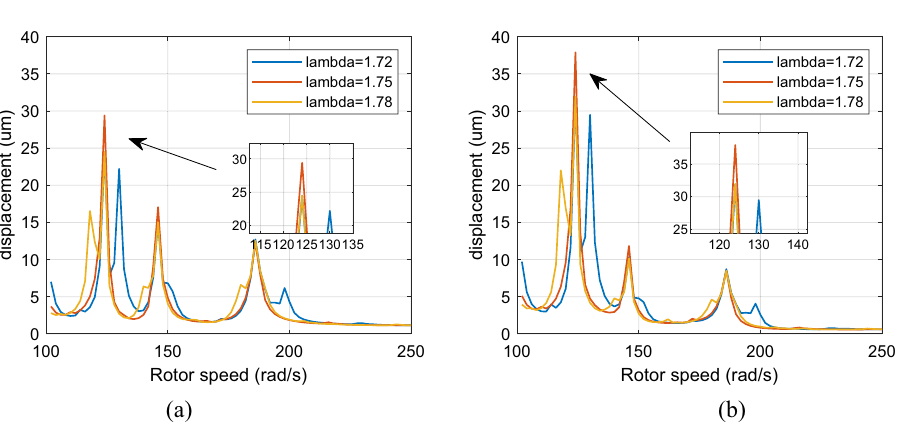
Figure 16. Amplitude-frequency response curve (λ = 1. 72, 1. 75, 1. 78, F 0 = 100, A max = 200, ψ = π) ( a ) LP rotor ( b ) HP